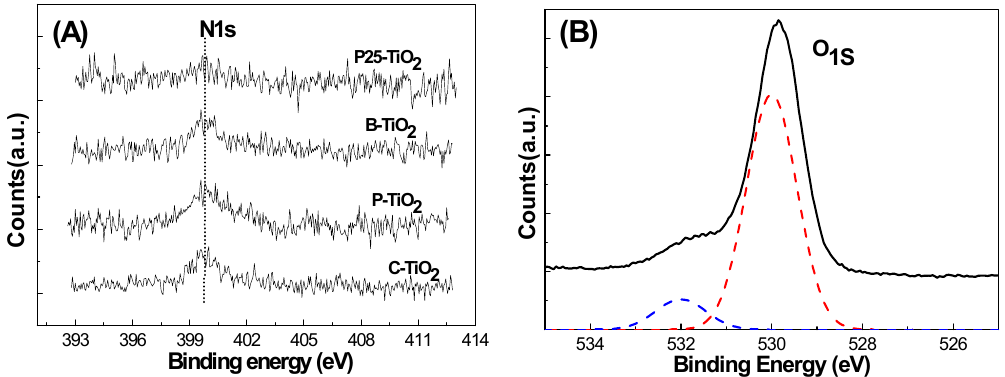
Figure 9. X-ray photoelectron spectroscopy (XPS) surveys of the three kinds of TiO 2 hollow spheres in the N1s region ( A ); and the high-resolution XPS survey of C-TiO 2 in the O 1S region ( B ), where the solid curve is the original survey and the two dashed-line curves show the deconvoluted peaks.